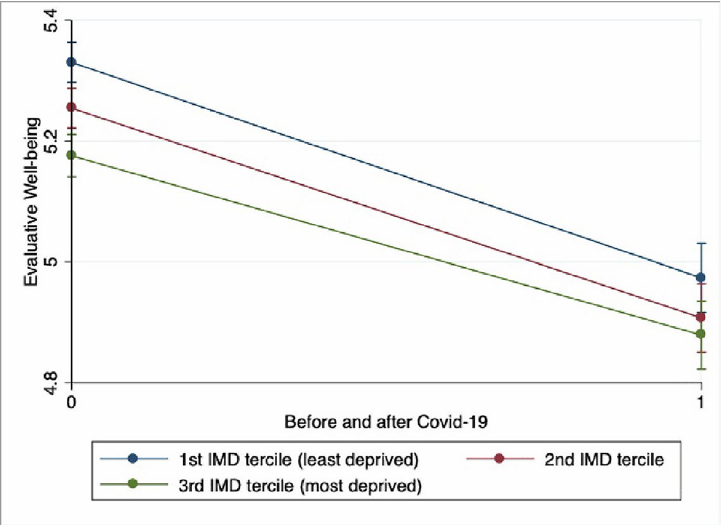
Fig 3. Change in Evaluative Well-being across the Covid-19 outburst by neighbourhood deprivation terciles. Authors computation on Understanding Society.